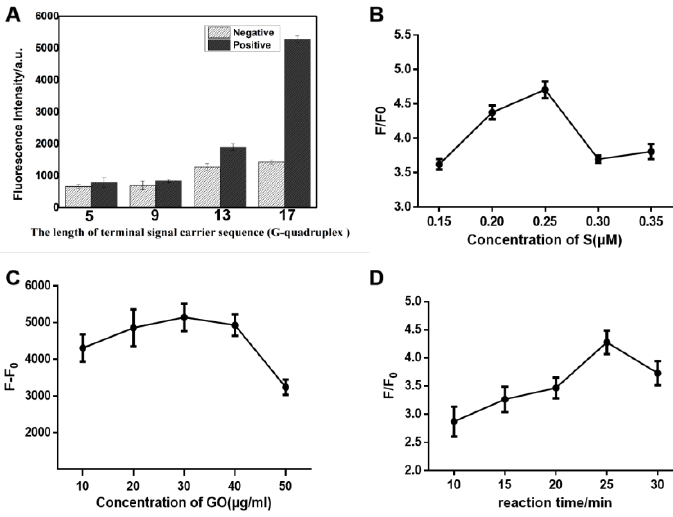
Figure 2. ( A ) E ff ect of the length of the terminal signal carrier sequence (G-quadruplex) upon fluorescence emission spectra; ( B ) E ff ect of the concentration of S upon fluorescence emission spectra; ( C ) E ff ect of the concentration of GO upon fluorescence emission spectra; ( D ) E ff ect of the reaction time between G-quadruplex structure and NMM upon fluorescence emission spectra. The error bar was calculated in three independent experiments.